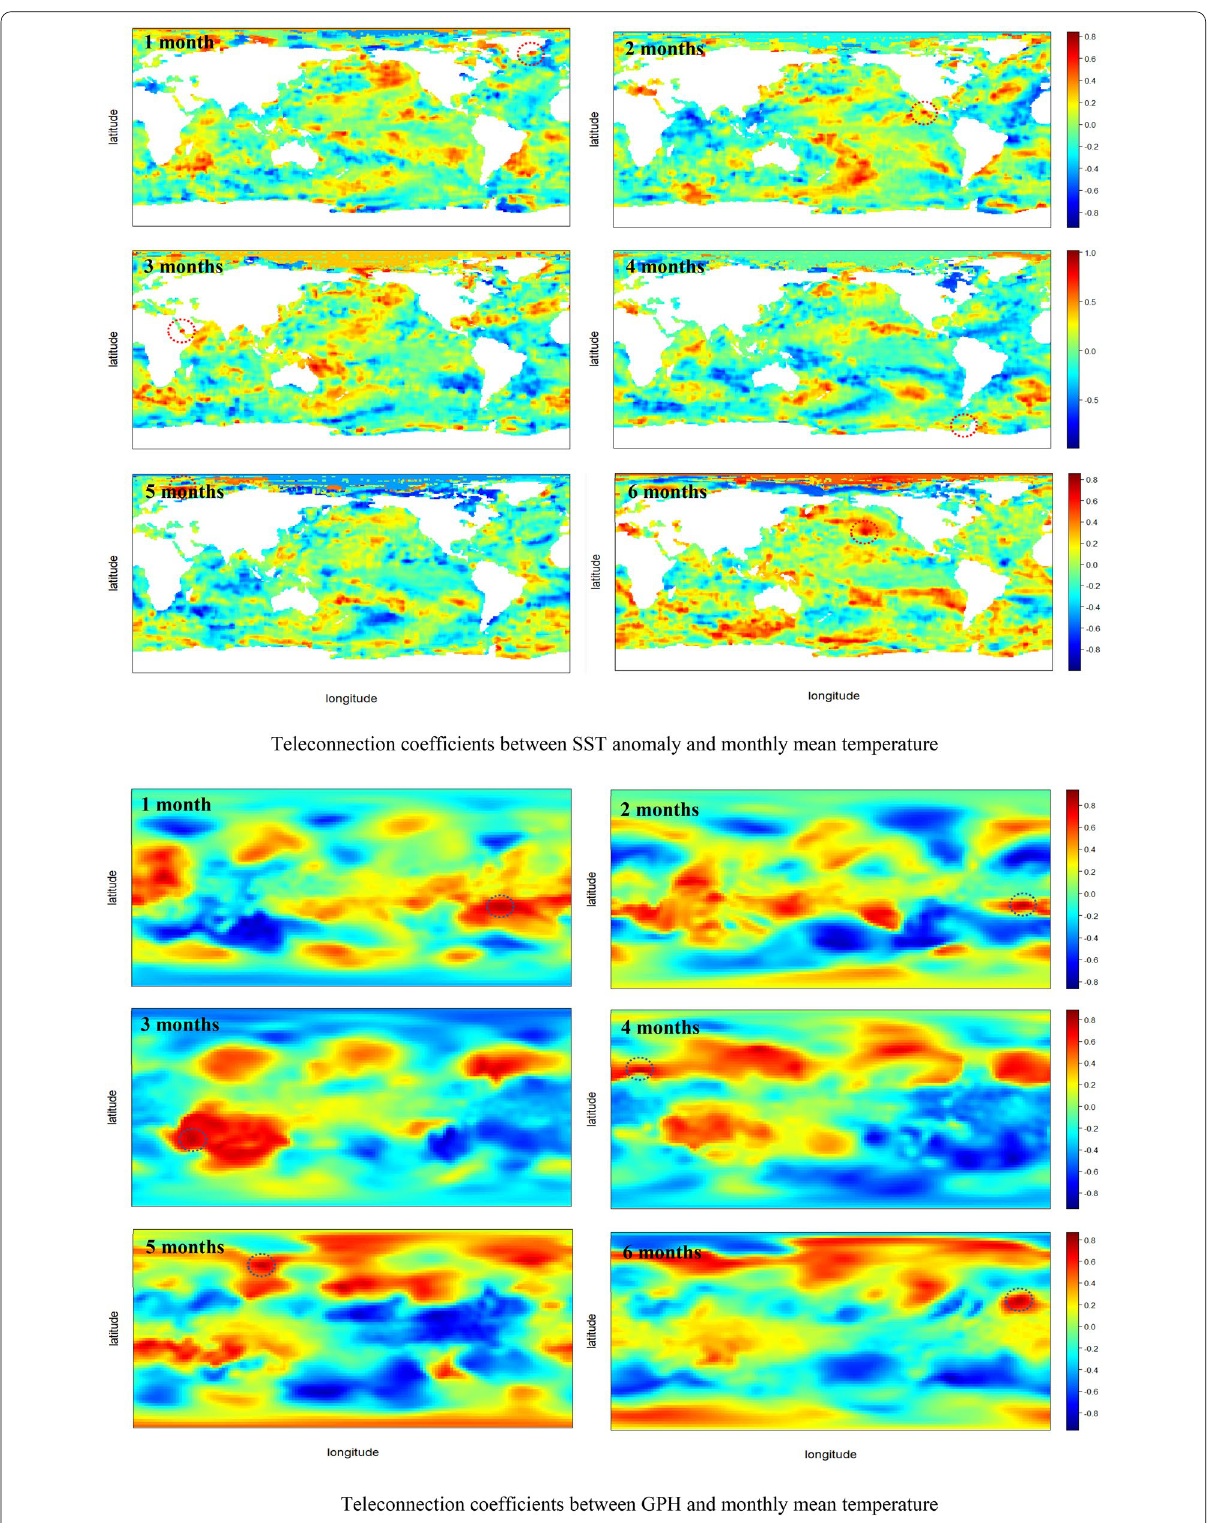
Fig. 31 Teleconnection coefficients between the global-scale climate indices and monthly mean temperature during the La Niña